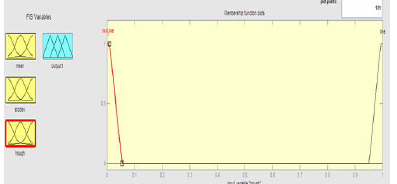
Figure 12: Input linguistic variable- hough